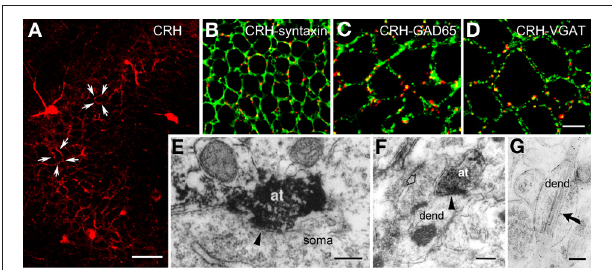
FIGURE 2 | CRH is located in GABAergic axonal terminals. (A) CRH-ir axon terminals form dense perisomatic baskets (arrows) around pyramidal cells in hippocampal area CA3. (B) CRH immunoreactivity localizes to pre-synaptic terminals, demonstrated by dual-labeled immunocytochemistry for CRH and for the pre-synaptic marker syntaxin. (C,D) CRH-containing terminals are GABAergic boutons as indicated by overlapping immunoreactivities of CRH and GAD65 (C) and of CRH and the GABA synaptic vesicular transporter VGAT (D) in axon terminals. (E) CRH-ir axon terminals (at) form axosomatic symmetric synapses (arrowhead) with pyramidal cell body (soma). (F) CRH-ir axon terminals form axodendritic asymmetric synapses (arrowhead) with dendrites (dend). Empty arrow indicates a bouton containing CRH-negative vesicles. (G) Electron micrograph demonstrating CRH-ir gold particles (arrow) within the dendrite, but not within vesicles. Scale bars = 50 μ m (A) , 10 μ m in (D) (25 μ m for B and 12.5 μ m for C ), and 0.2 μ m (E–G) . Reproduced, with permission, from Chen et al. (2004b) (B–D) and Yan et al. (1998) (E) .